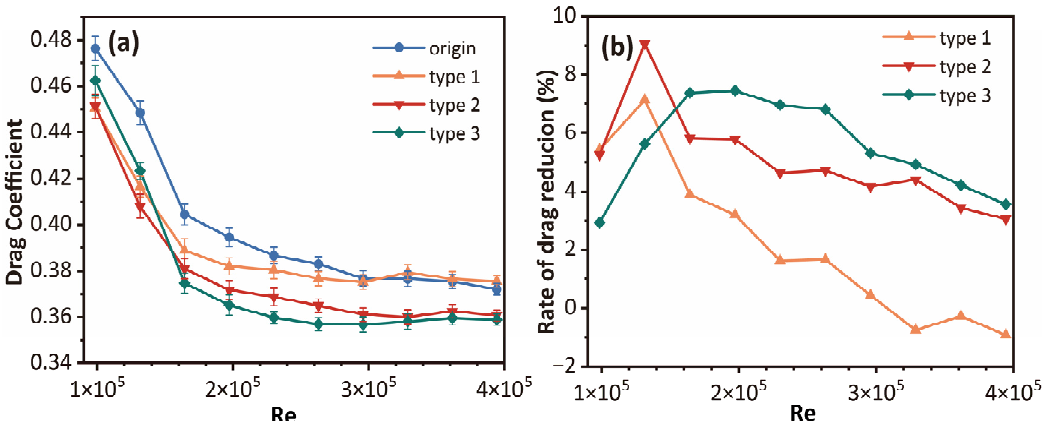
Figure 11. The wind tunnel results for 𝐶 (cid:3031) and 𝜂 : ( a ) the 𝐶 (cid:3031) respect to Re , ( b ) 𝜂 respect to Re